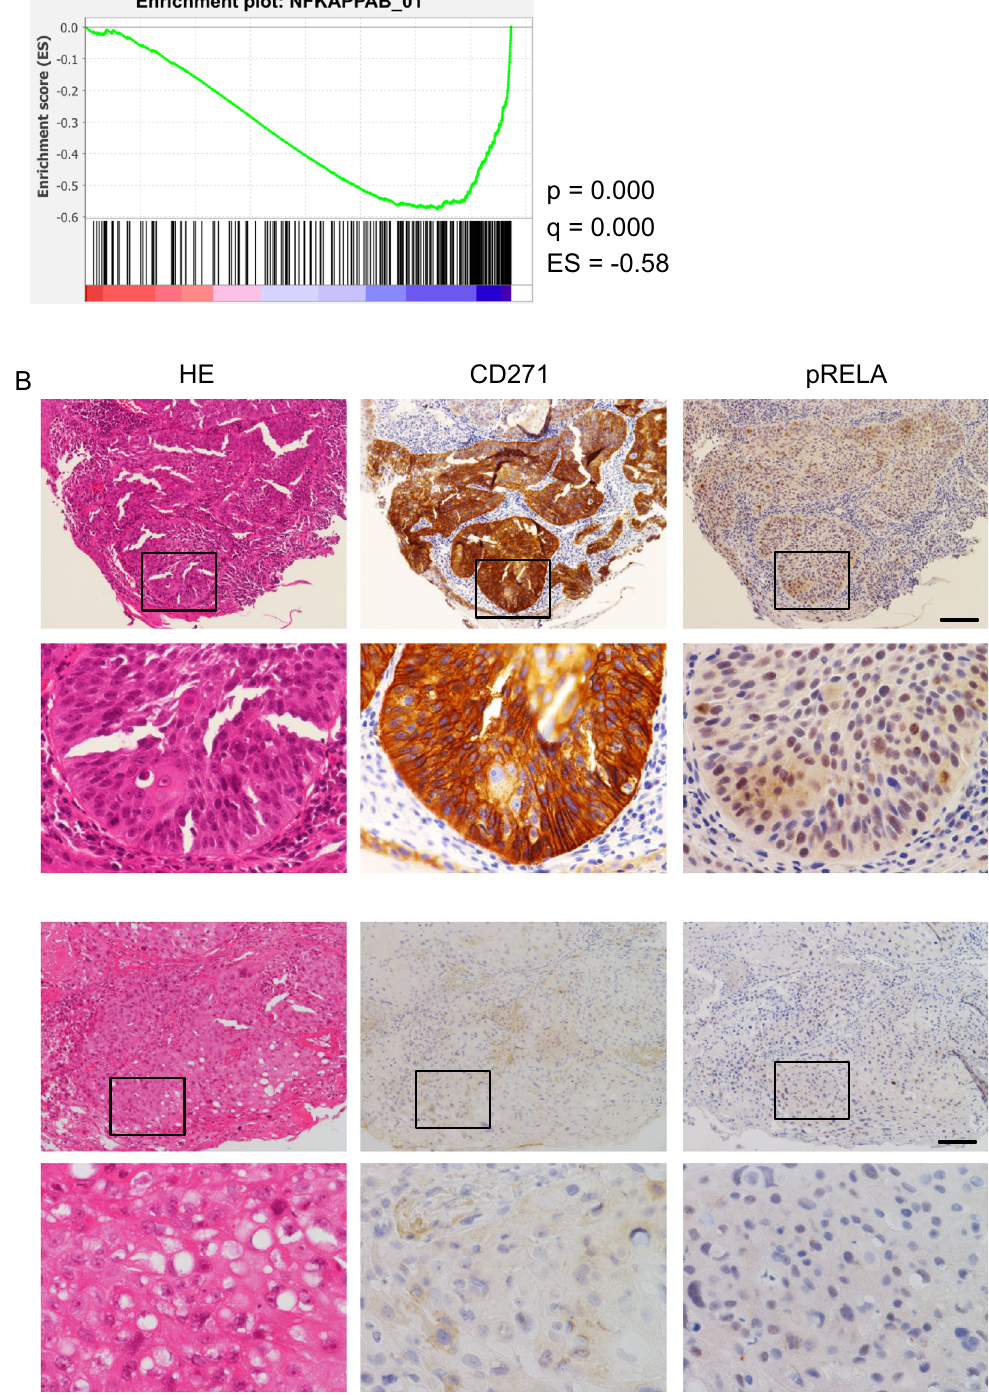
Figure 6. Correlation of RELA and CD271 levels in clinical specimens. ( A ) Enrichment plot calculated using GSEA software. HNSC data from TCGA was divided into CD271-high and -low samples, and RELA-binding sites were identified. ES, enrichment score. ( B ) Surgical resection specimens were stained with anti-CD271 or anti-p-RELA. Upper panels show a sample where both CD271 and p-RELA were upregulated, and the lower panel shows a sample where neither was expressed. Bar, 100